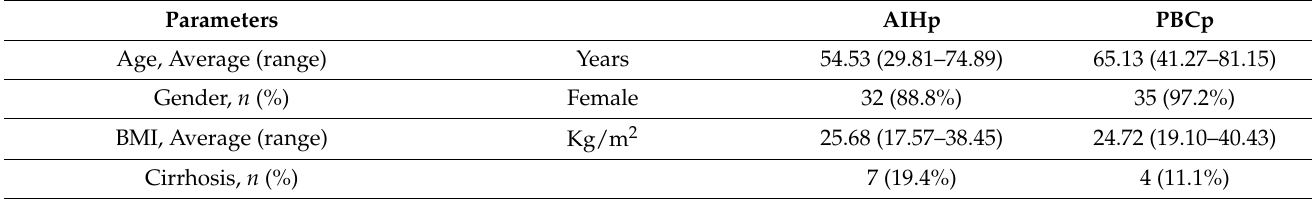
Table 1. Clinical features and pharmacological treatment of AIHp and PBCp included in the study measured at the time of saliva